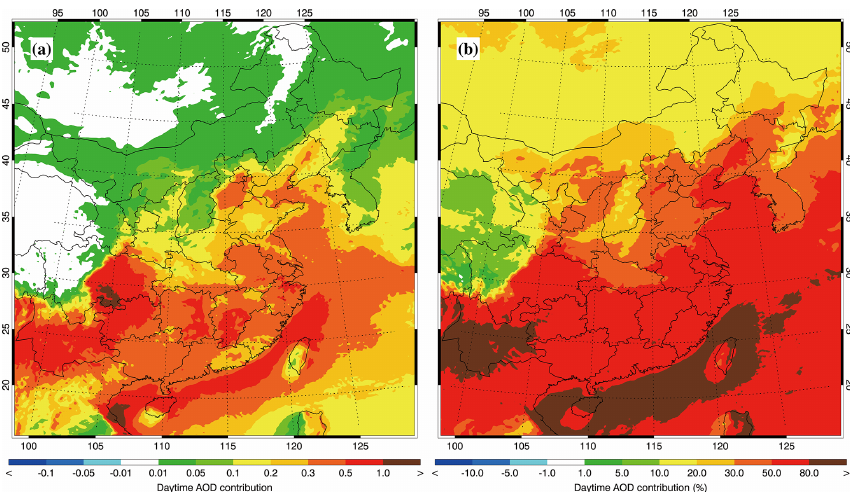
Figure 5. Average (a) absolute and (b) relative AOD contribution caused by the ALW from 5 December 2015 to 4 January 2016.